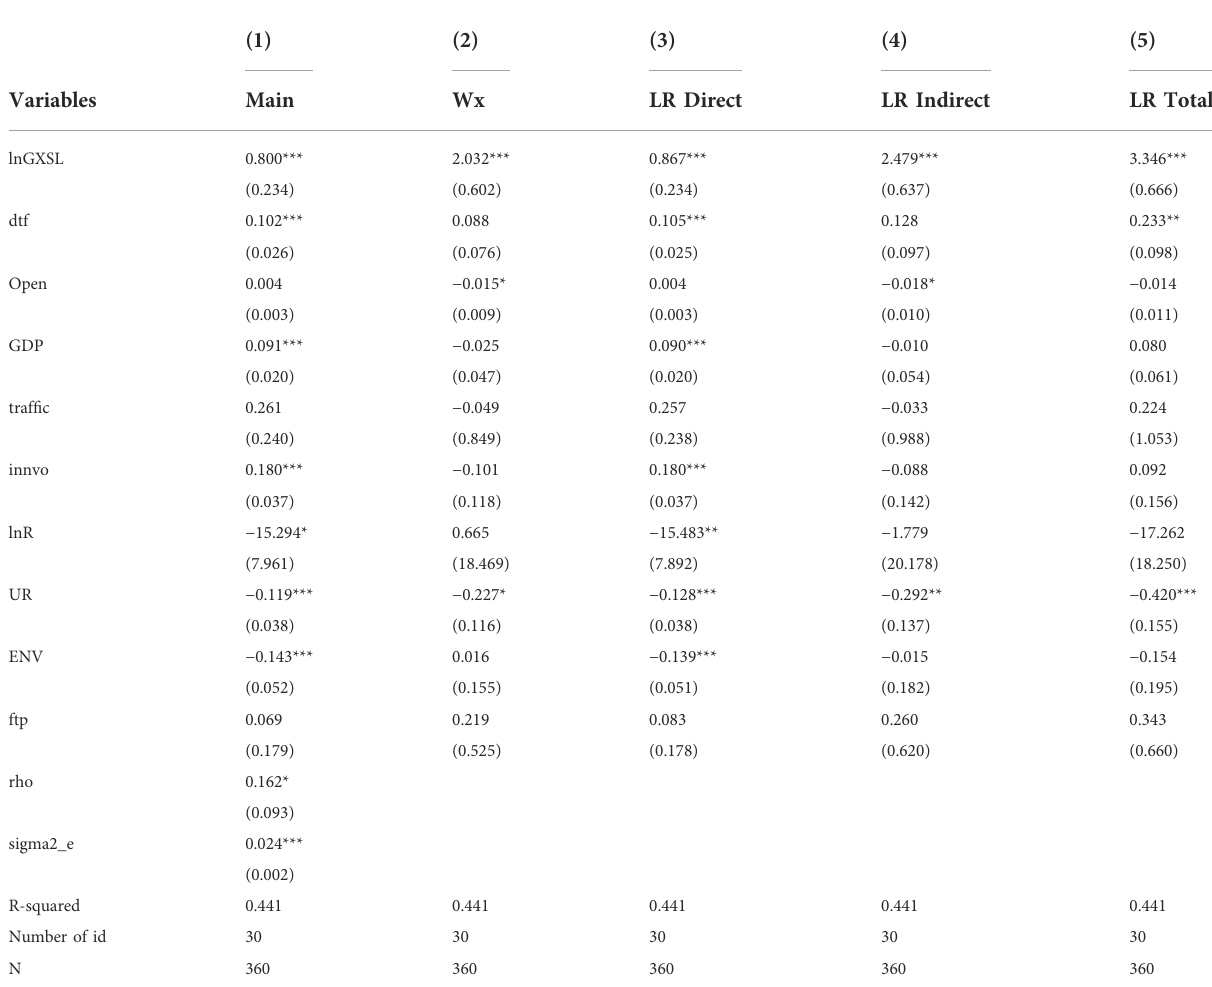
TABLE 12 Robustness